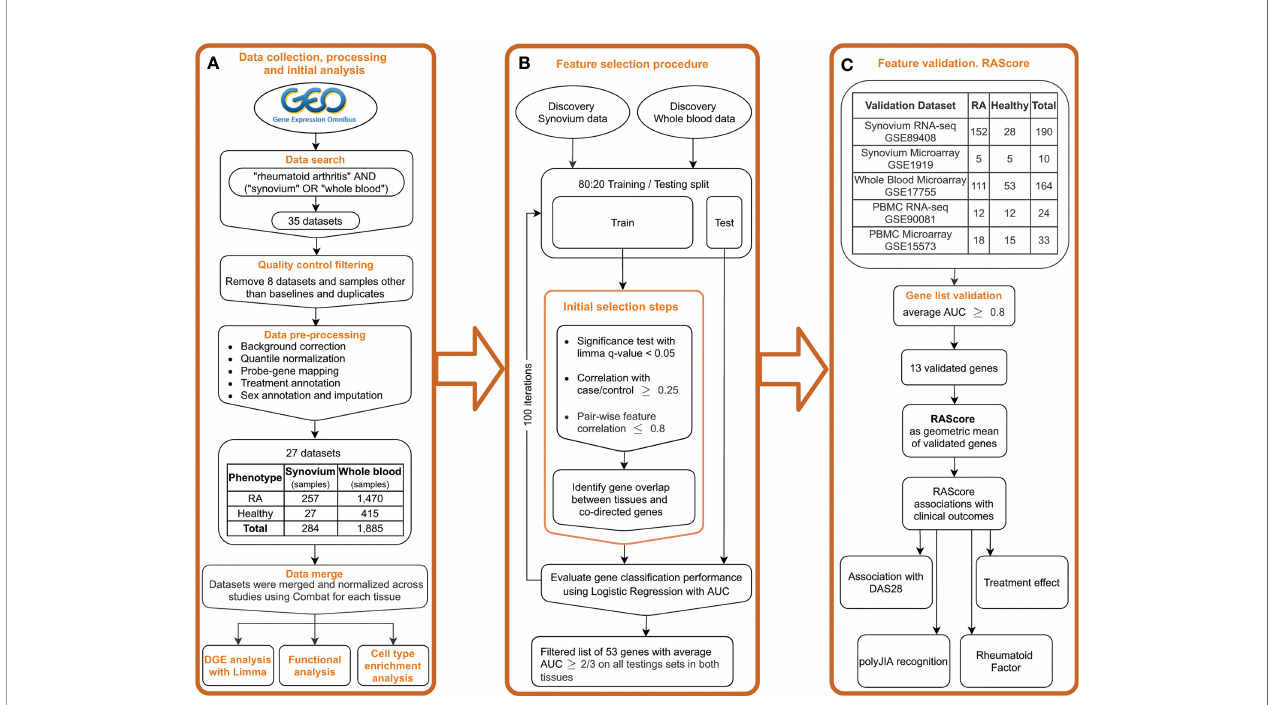
FIGURE 1 | Study overview. (A) Public data collection, processing and DGE analysis. (B) Feature selection pipeline. (C) Gene list validation on the independent datasets. Introducing the RA Score as a geometric mean of validated genes and its association with clinical